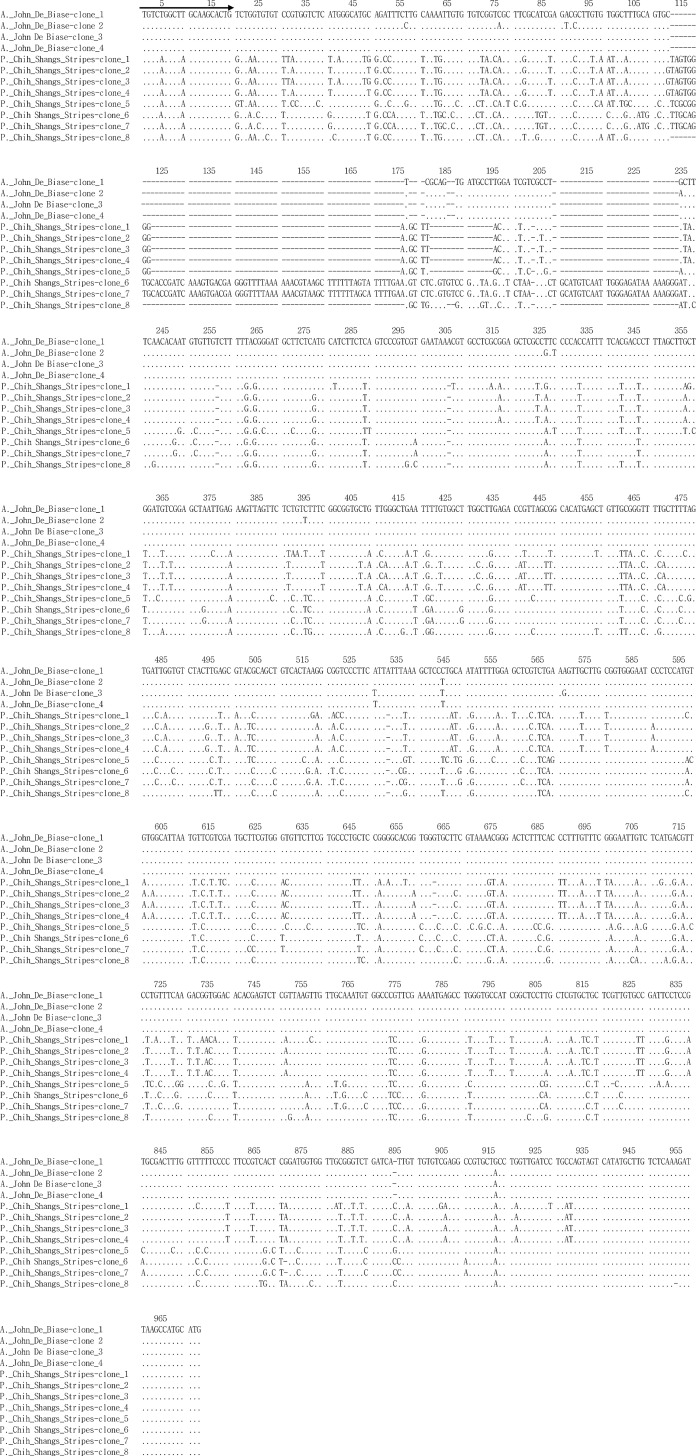
The alignment of validated ETS sequence derived from both the male parent (Phalaenopsis Chih Shang's Stripes) and female parent (Ascocenda John De Biase ‘Blue’).The Arrow represents the location of the forward primer for the ETS amplification by PCR.